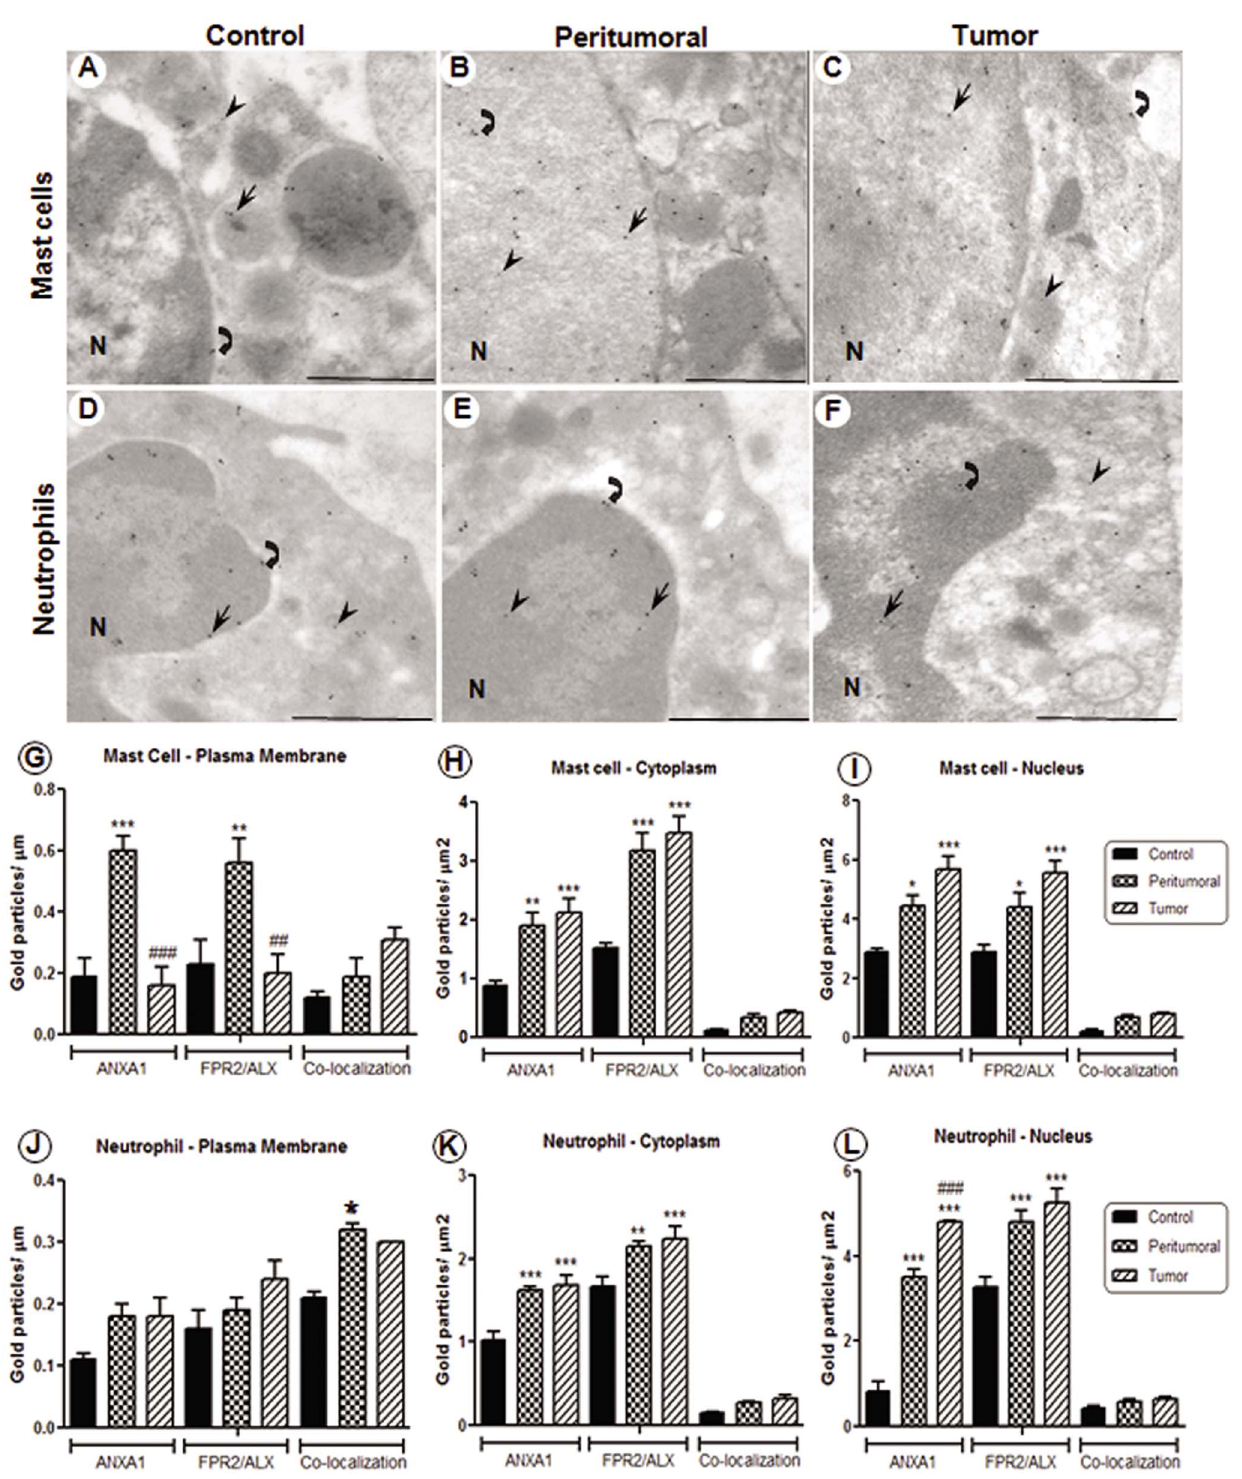
Fig. 2. Immunoreactivity to ANXA1 and FPR2/ALX in mast cells and neutrophils of laryngeal sections. Immunolabeling with 10-nm (FPR2/ALX) and 15-nm (ANXA1) colloidal gold particles. Mast cells ( A–C ) and neutrophils ( D–F ) showing subcellular localization of ANXA1 (arrows) and FPR2/ALX (arrowheads), and co-localization (curve arrows) in the plasma membrane, cytoplasm and nucleus (N) of control, peritumoral and tumor tissues. Density of